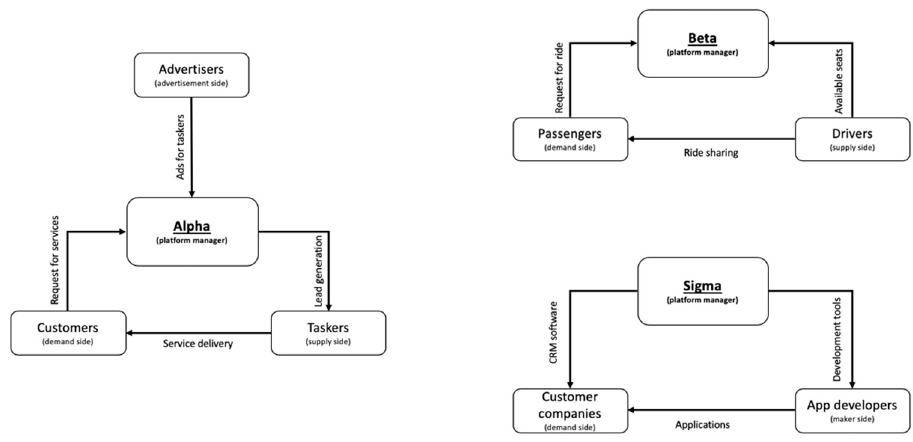
Figure 4. Platform sides in the three case studies.